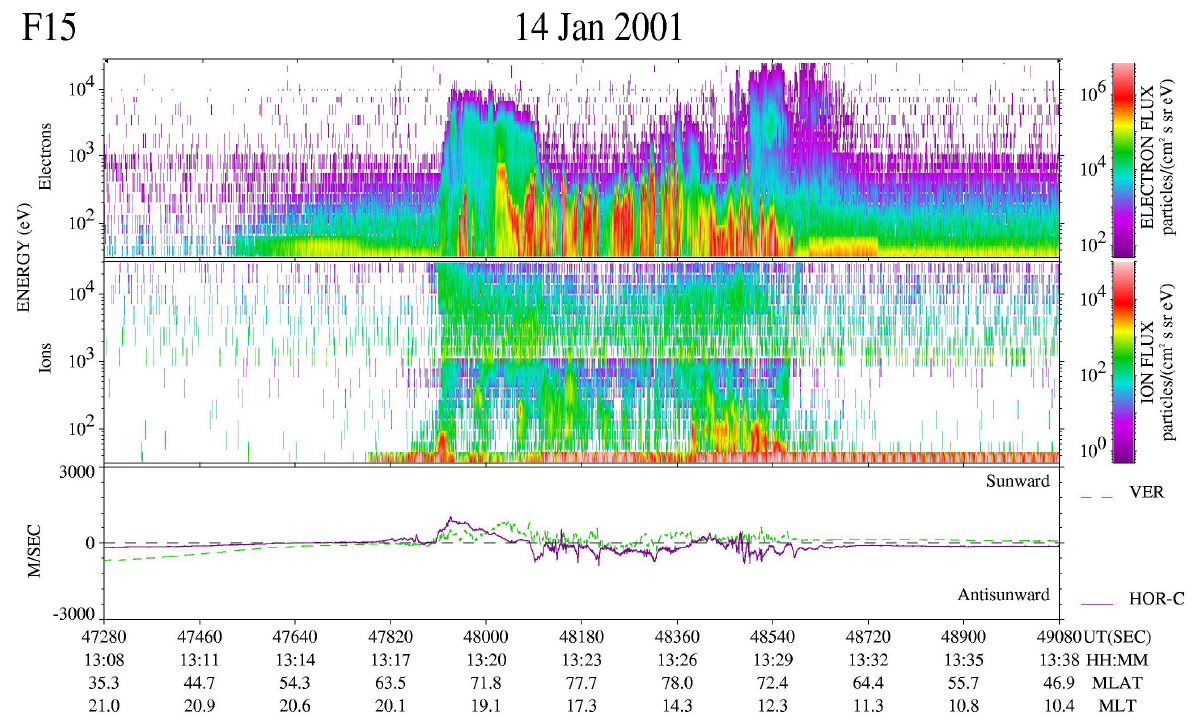
Fig. 24. From top to bottom: electron and ion spectrograms and plasma flow measurements by the DMSP F15 satellite during a passage over Greenland from 13:08 to 13:38 UT on 14 January 2001 (see Fig. 2 for the orbit projection to the